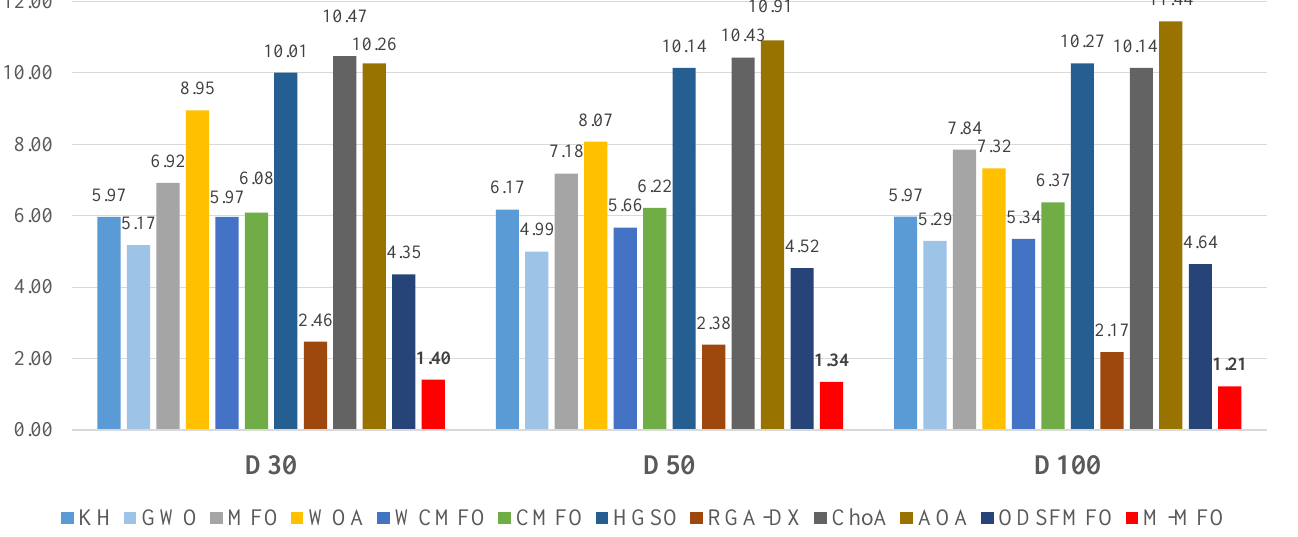
Figure 7. Friedman’s test average results in different dimensions.